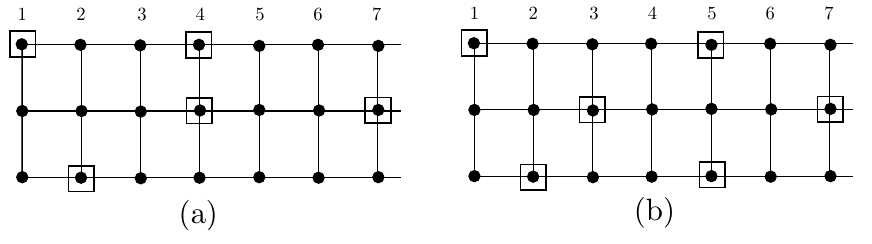
Figure 9: A guard at the top vertex of column 1 in the 3